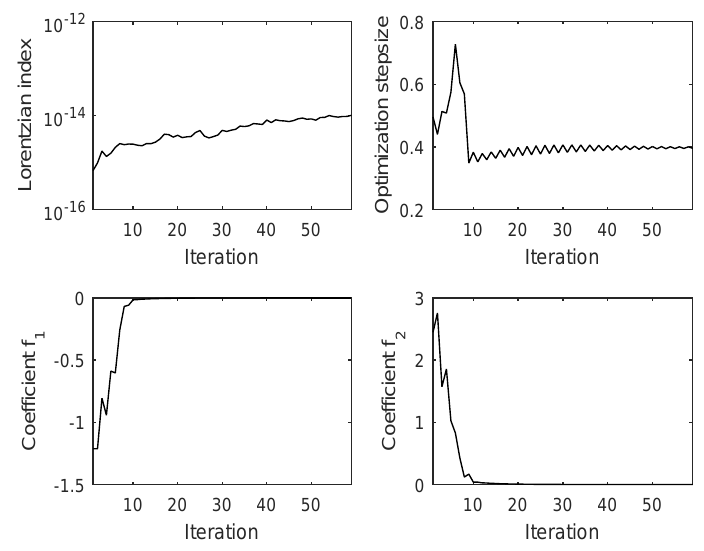
Figure 4. Minimization of the criterion function in Equation (28) over the pseudo-orthogonal R p , q X ( (cid:96) ) − R p , q (cid:107) F and of the coefficients ˆ t ( (cid:96) ) , ˜ f 1 ( (cid:96) ) and ˜ f 2 ( (cid:96) ) group O ( 5,5 ) : Values of the index (cid:107) X (cid:62) ( (cid:96) ) during iteration.